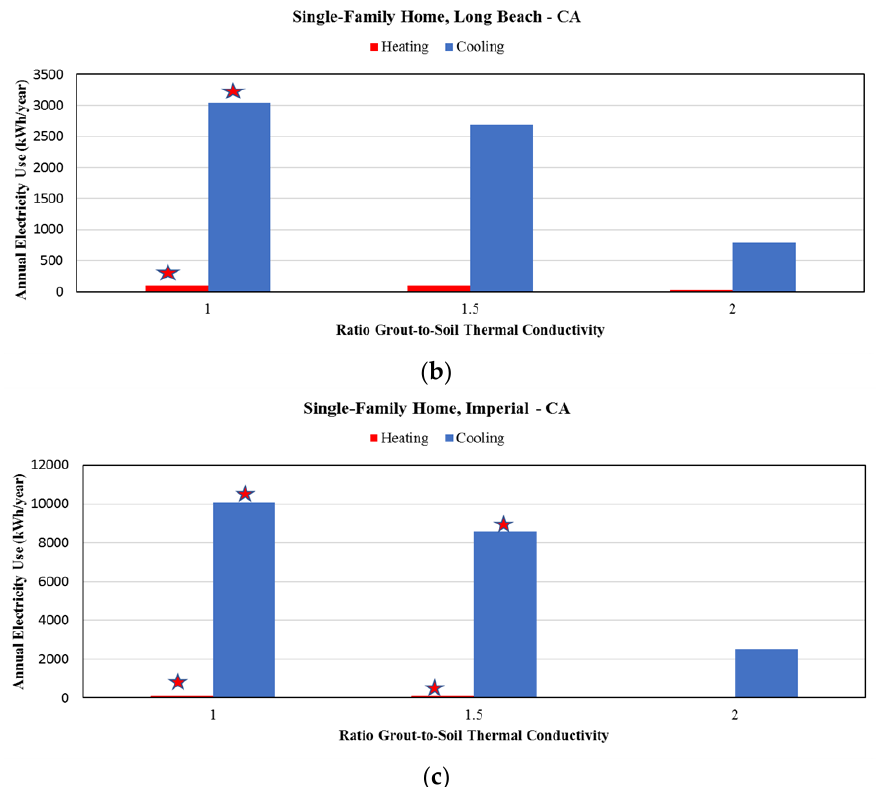
Figure 11. Impact of grout thermal conductivity on annual heating and cooling electricity end uses for 16 boreholes with 6.7 m (22 ft) depth when the prototypical house is located in ( a ) Arcata, ( b ) Long Beach, and ( c ) Imperial.